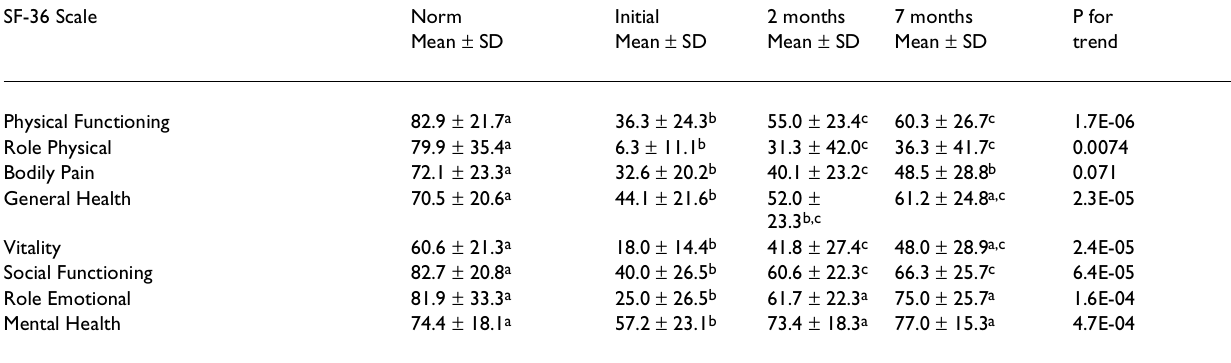
Table 4: SF-36 Results. Norm data is for women aged 45–54 [20]. N = 20 at each time point. SF-36